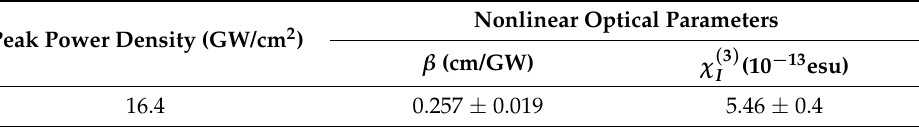
Table 3. The nonlinear optical parameters of BTS crystal at λ = 532 nm.